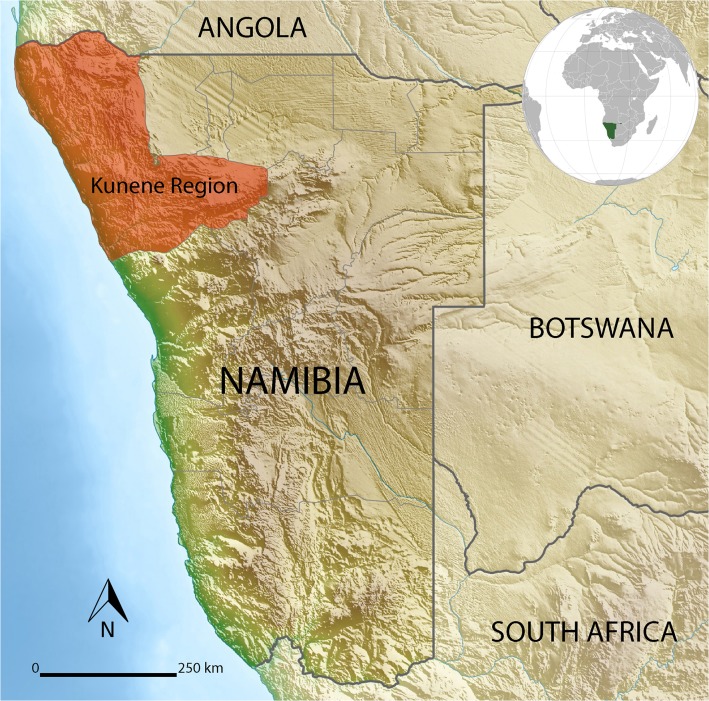
The location of the Kunene Region (red shaded area) in north-western Namibia (sourced from https://en.wikipedia.org/wiki/Template:Location_map_Namibia/doc).